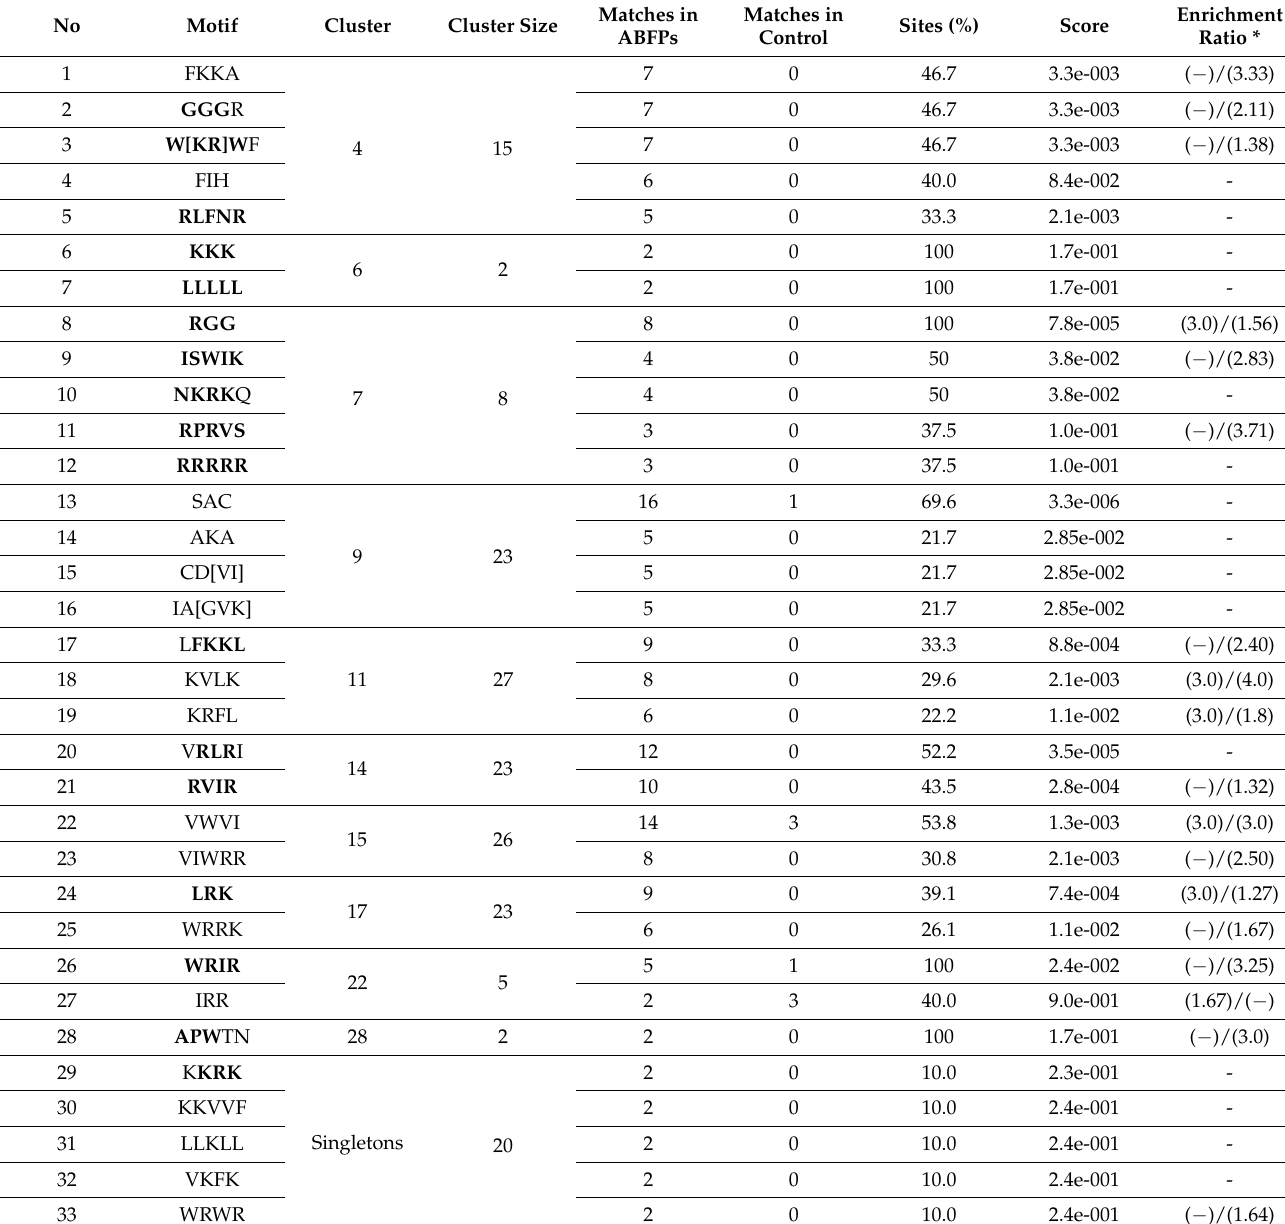
Table 6. Motifs identified by STREME at each network